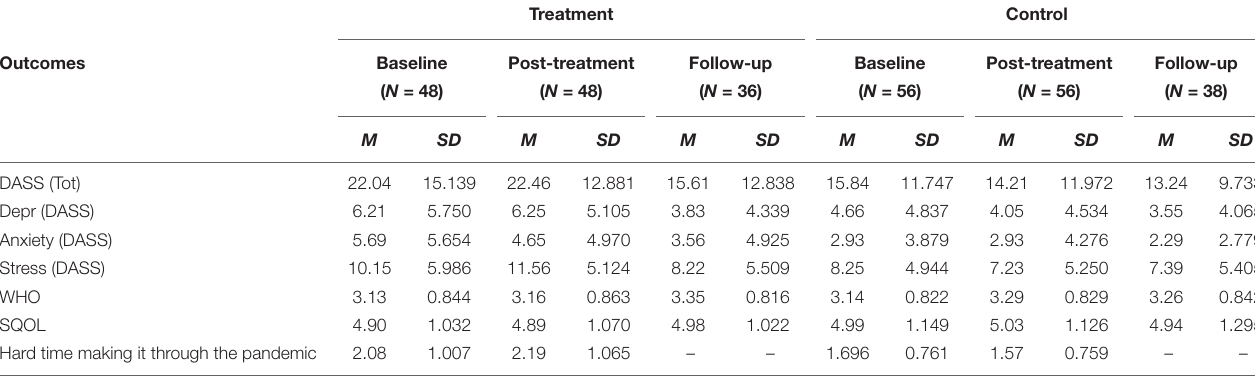
TABLE 2 | Descriptive statistics for primary and secondary outcomes for treatment and control groups across baseline, post-treatment, and follow-up.